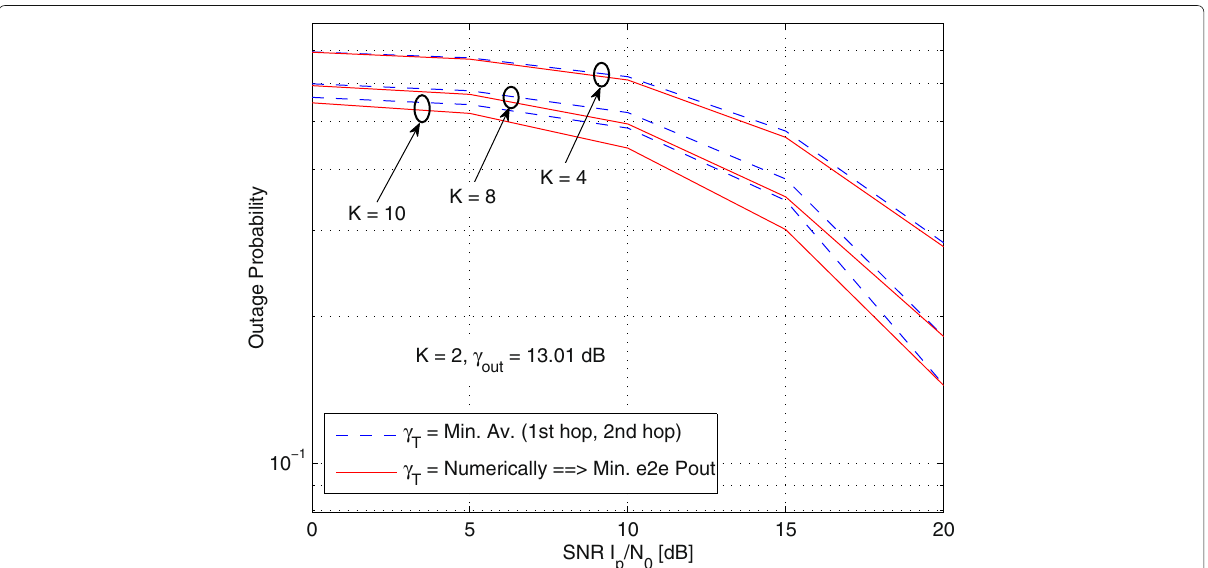
Fig. 6 Outage probability vs SNR of cognitive AF relay network with MUSwiD user selection scheme for different values of γ T and (cid:3) s,p = 7, and (cid:3) = 0.91, (cid:3) = 0.73, (cid:3) = 0.82 for k = 1,2 s,r r,p r, k